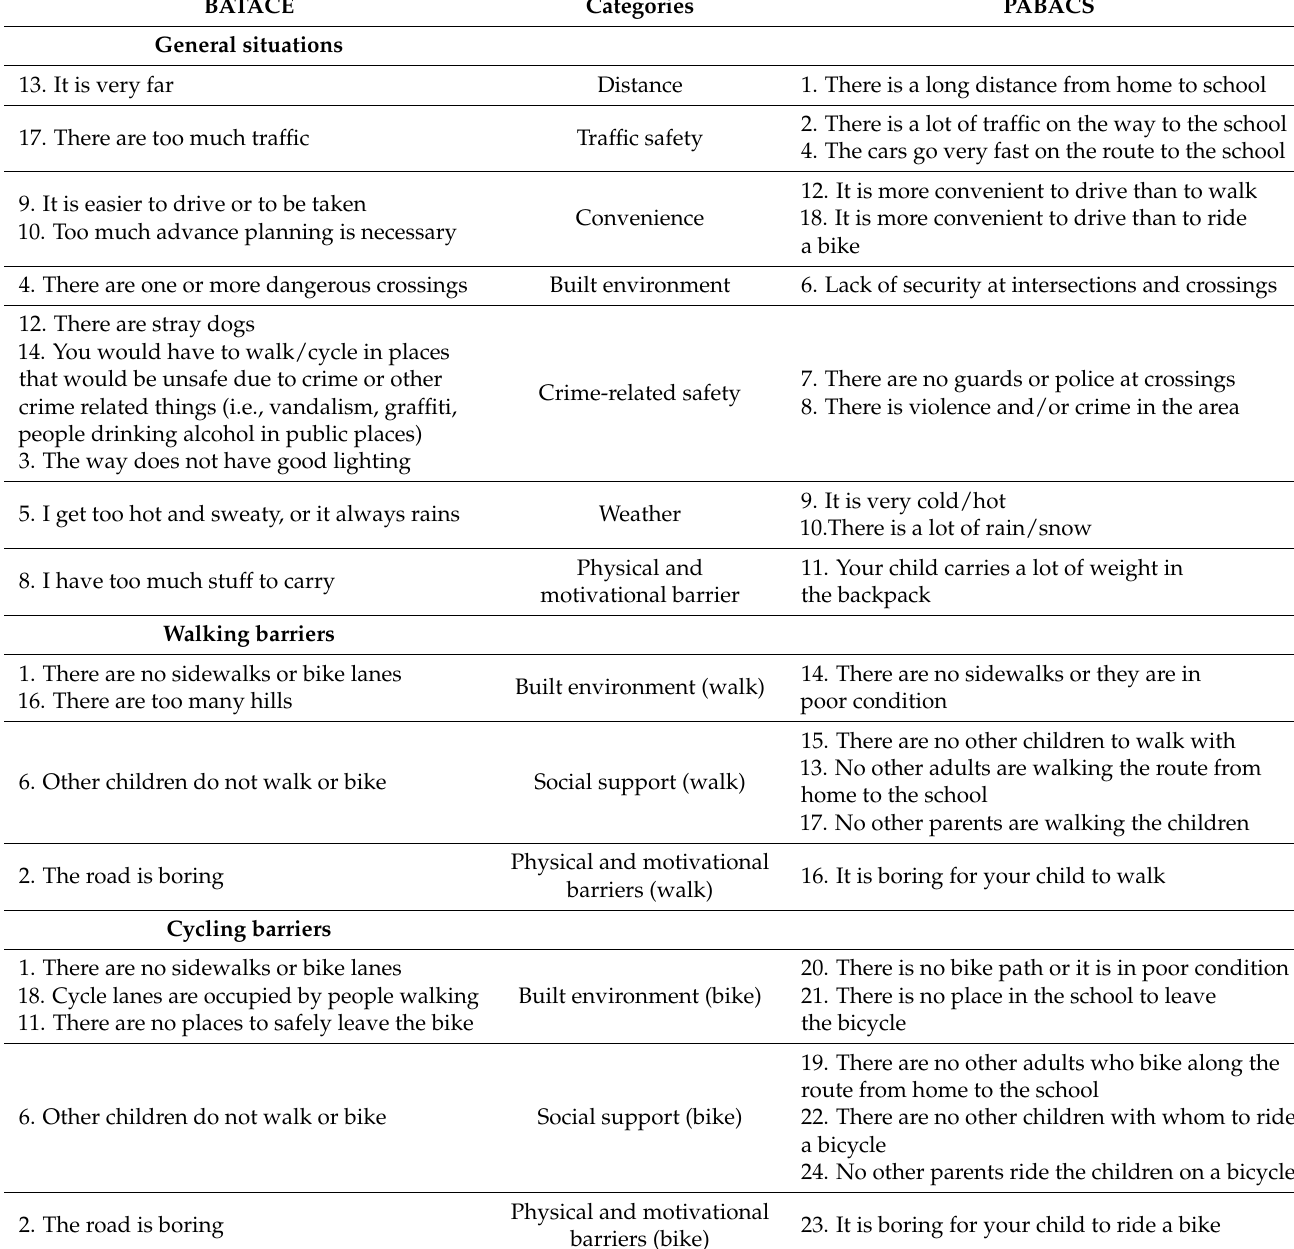
Table 1. Categorization of the barriers presented in the Barreras en el Transporte Activo al Centro Educativo (BATACE) and Parental Perception of Barriers Towards Active Commuting to School (PABACS)